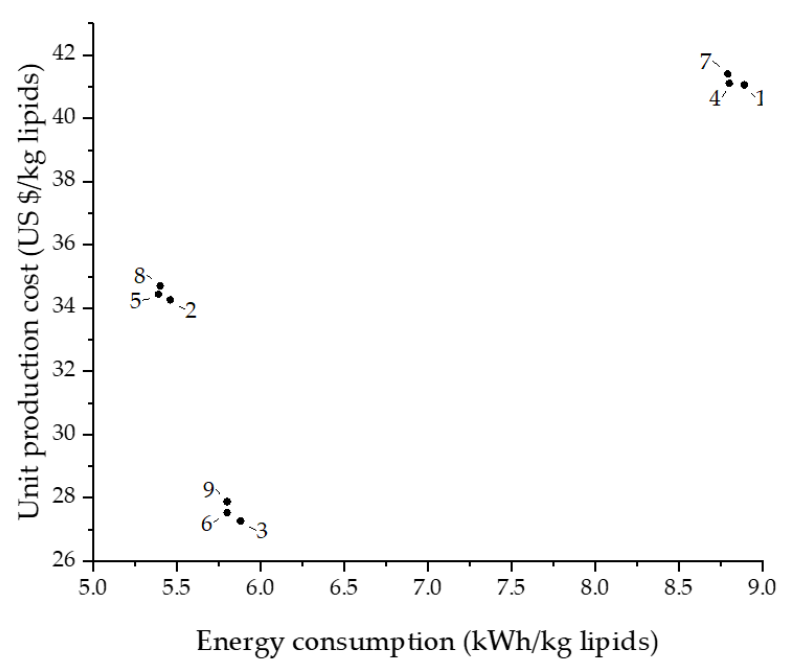
Figure 10. Total energy consumption vs. total production cost per kg lipids produced in each scenario.